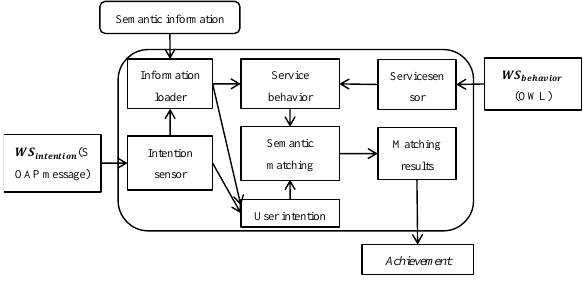
Figure. 7 Assemble model for pragmatics web service composition